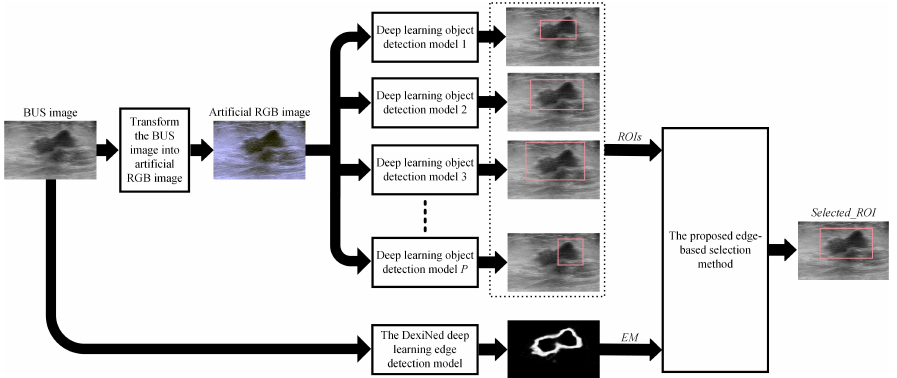
Figure 3. Graphical illustration of the process employed to apply the proposed edge-based selection method to analyze the ROIs generated by different deep learning object-detection models. Table 1. Comparison of the four deep learning object-detection models used to localize ROIs that contain the tumors in BUS